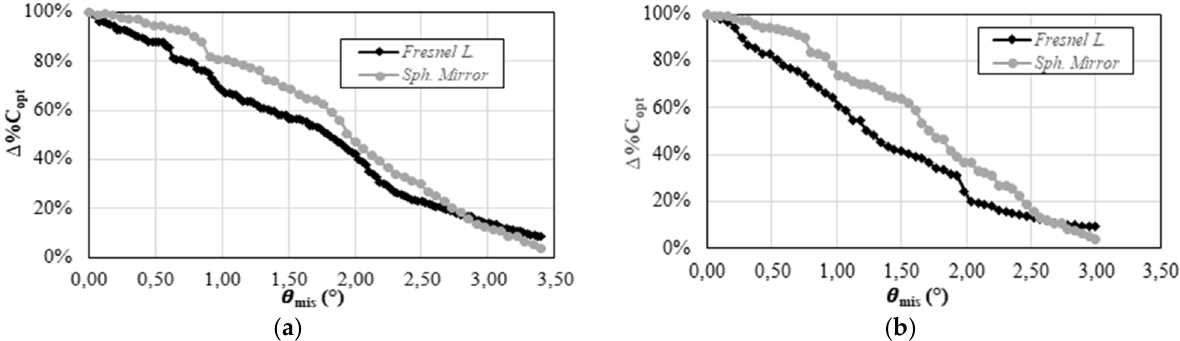
Figure 11. Percentual reduction of C opt as a function of the misalignment angle ( θ mis ) for Fresnel lens and spherical mirror in the cases with ( a ) and without ( b ) secondary optics.